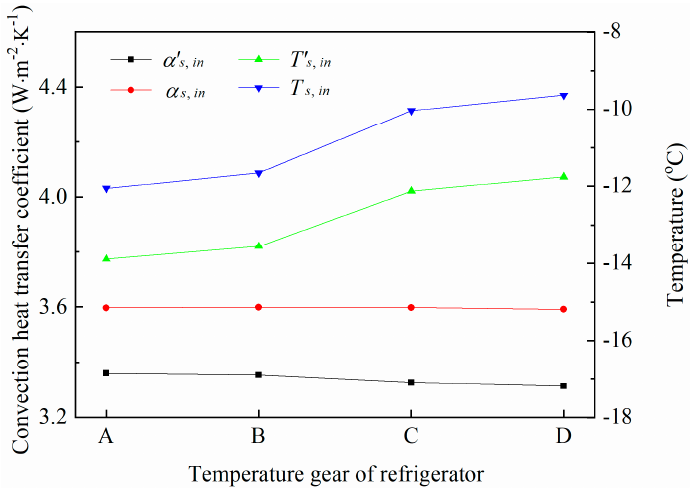
Figure 8. Inside heat transfer characteristics of the topside freezer wall at various temperature gears.